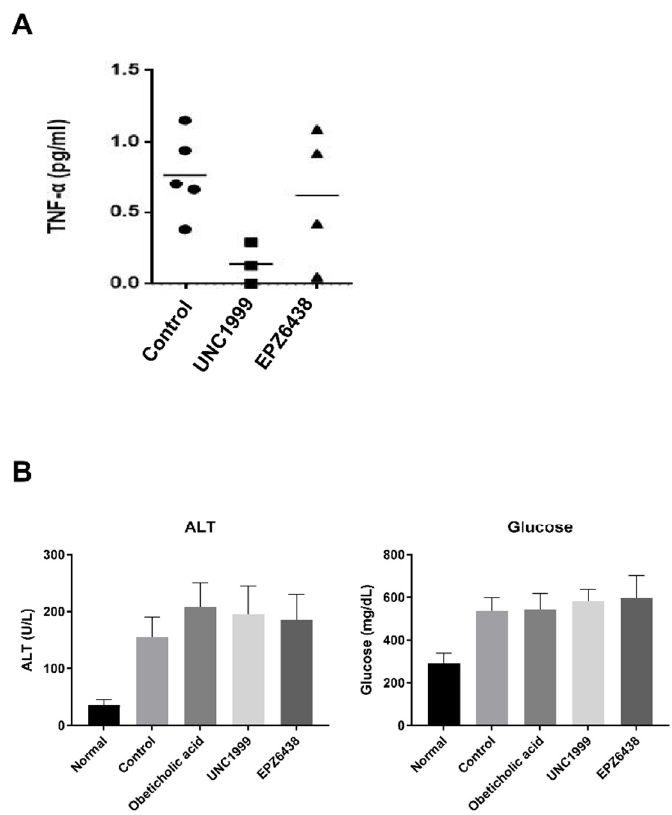
Figure 3. Treatment with EZH2 inhibitors attenuates liver inflammation in STAM NASH mice. ( A ) Effect of EZH2 inhibitors (UNC1999, EPZ-6438) treatment on the serum levels of tumor necrosis factor-α (TNF-α). ( B ) Effects of EZH2 inhibitors and obeticholic acid treatment on the serum levels of alanine aminotransferase (ALT) and glucose. Statistically significant differences versus NASH group and EZH2 inhibitors treatment group are marked as * p < 0.05, respectively.